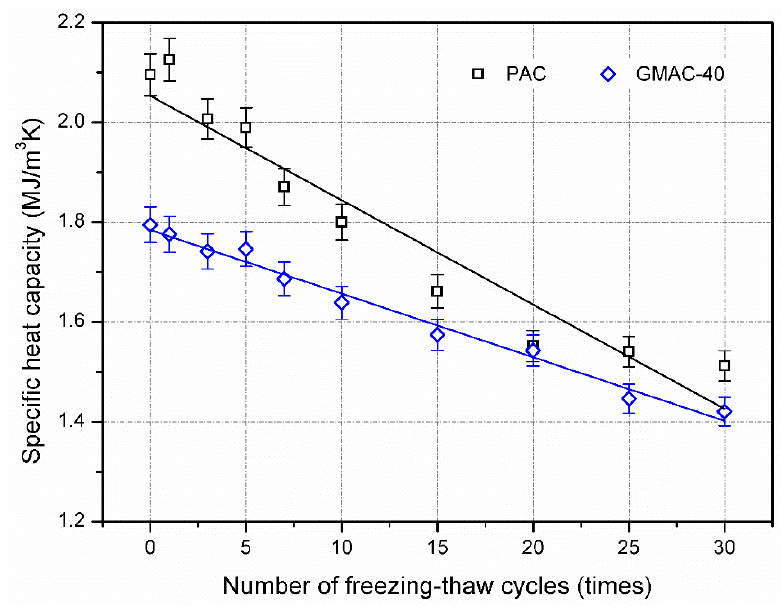
Figure 9. Specific heat capacity of asphalt mixtures after freezing–thawing cycles.